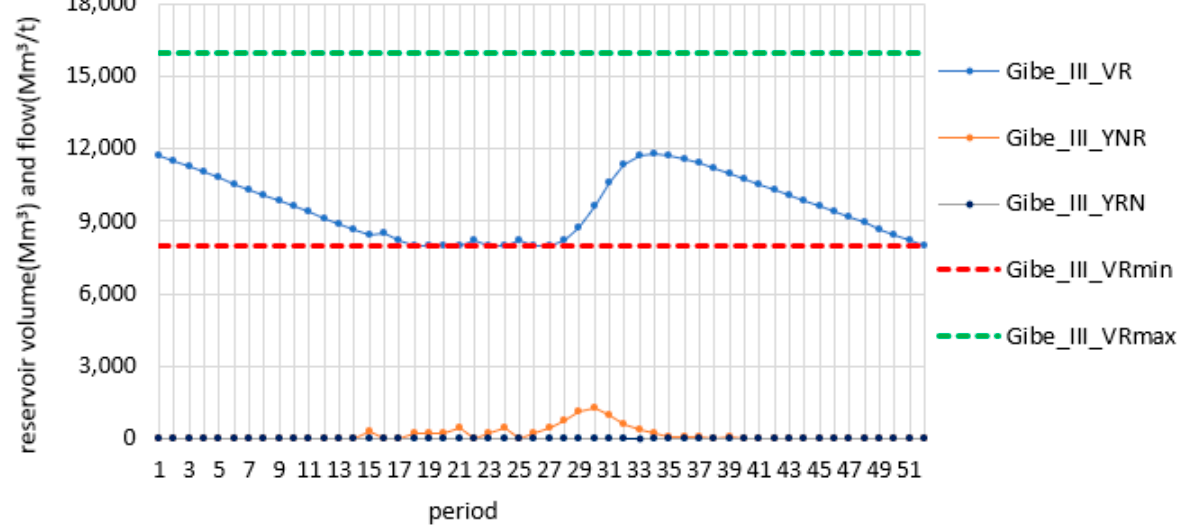
Figure 21. Gibe III reservoir volume storage and inflow/outflow from and to river link.